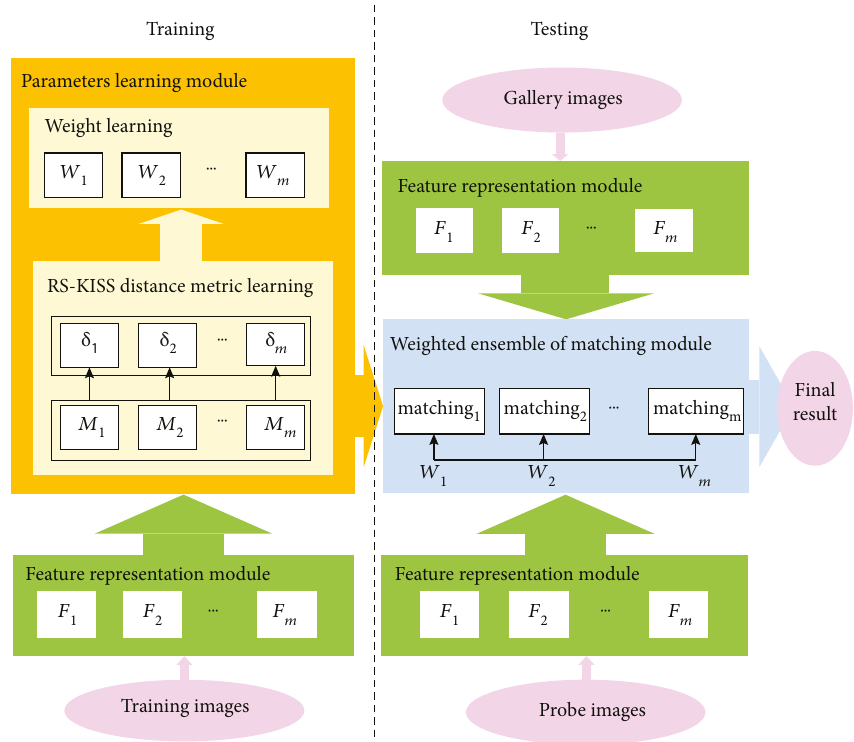
Figure 1: Person reidenti fi cation model by weighted ensemble learning with multiple feature